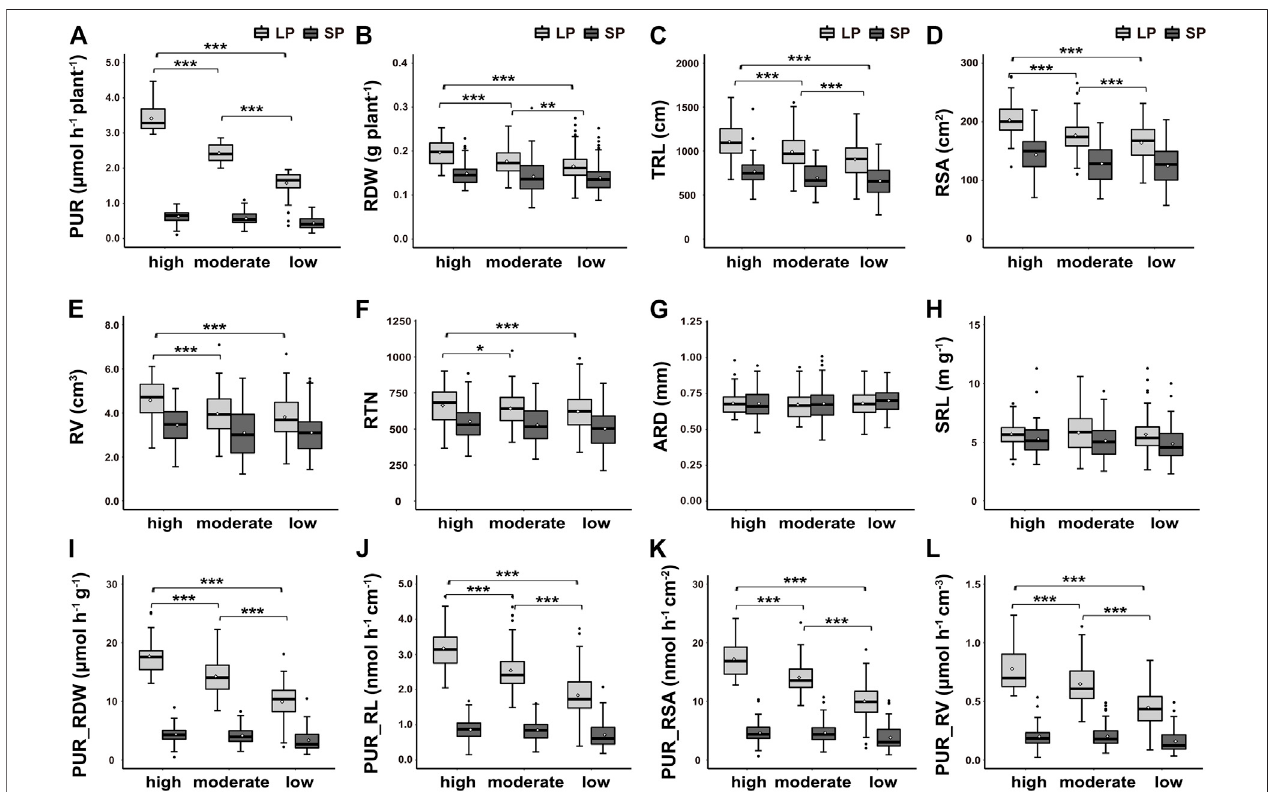
FIGURE 3 | Box and whisker plot showing differences in 12 traits among different P uptake capacity of peanut germplasms under low-P (LP) and suf fi cient-P (SP) treatments. (A) Puptakerateperplant(PUR), (B) rootdryweightperplant(RDW), (C) totaltootlength(TRL), (D) rootsurfacearea(RSA), (E) rootvolume(RV), (F) roottip number(RTN), (G) averagerootdiameter(ARD), (H) speci fi crootlength(SRL), (I) Puptakerateperunitrootdryweight(PUR_RDW), (J) Puptakerateperunitrootlength (PUR_RL), (K) P uptake rate per unit root surface area (PUR_RSA), and (L) P uptake rate per unit root volume (PUR_RV). High, moderate, and low represent high, moderate,andlowPuptakeratesper plant,respectively.Horizontallinesinsideboxes,median;whitedot,mean;boxhinges, fi rstand thirdquartiles;whiskers,fullrange of the data; black dots represent outliers. *, **, and *** indicate signi fi cance at p < 0.05, p < 0.01, and p < 0.001, respectively.